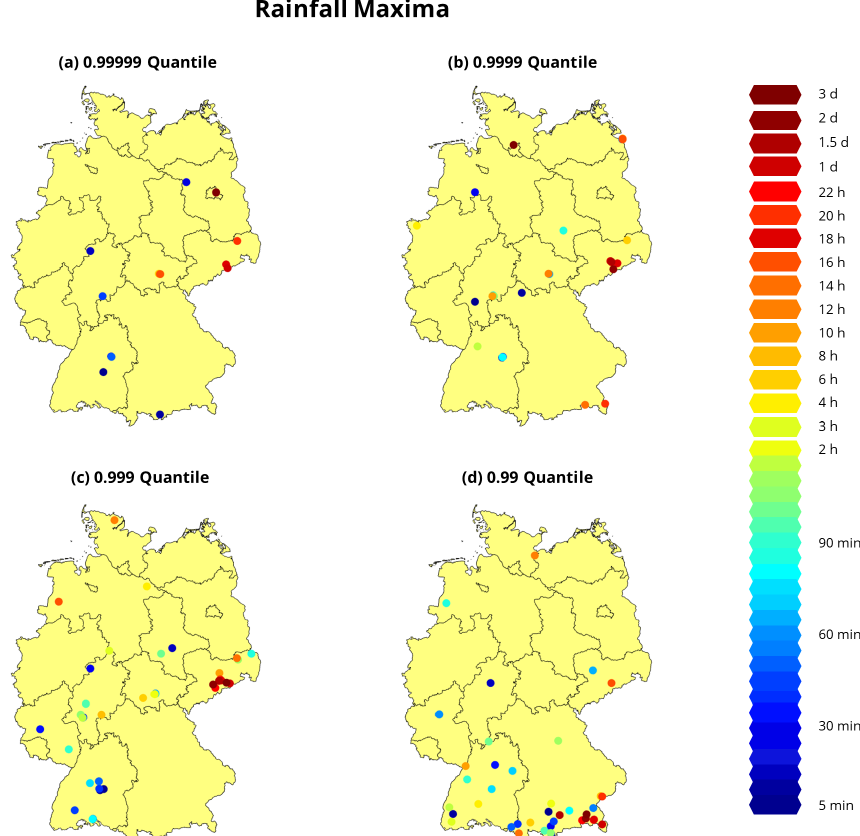
Figure 5. Locations of the 0.99999, 0.9999, 0.999, and 0.99 quantile rainfall with varying durations from 5min to 3d. Point colours represent the corresponding rainfall duration, similar for each quantile. Different numbers of data points in panels (a) – (d) result from several data points being at the same